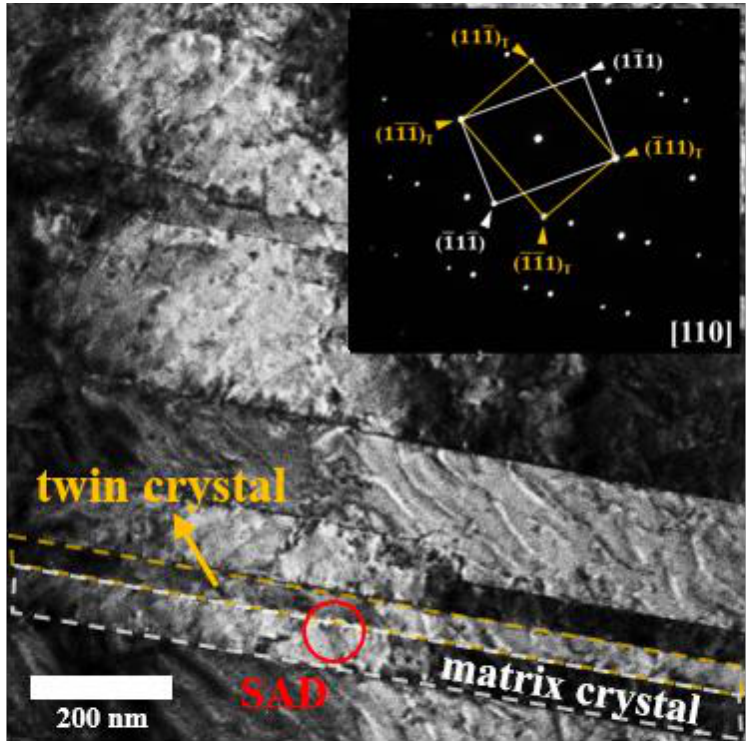
Figure 2. Bright-field TEM image showing the microstructure of twin grain structure of the nt-Cu films and its selected area diffraction pattern, respectively. Table 1. The average twin-boundary density and twin spacing for the nt-Cu films plated with the concentration of gelatin (8 g/L), (7.9 g/L), and (7.8 g/L). Concentration of Gelation 8